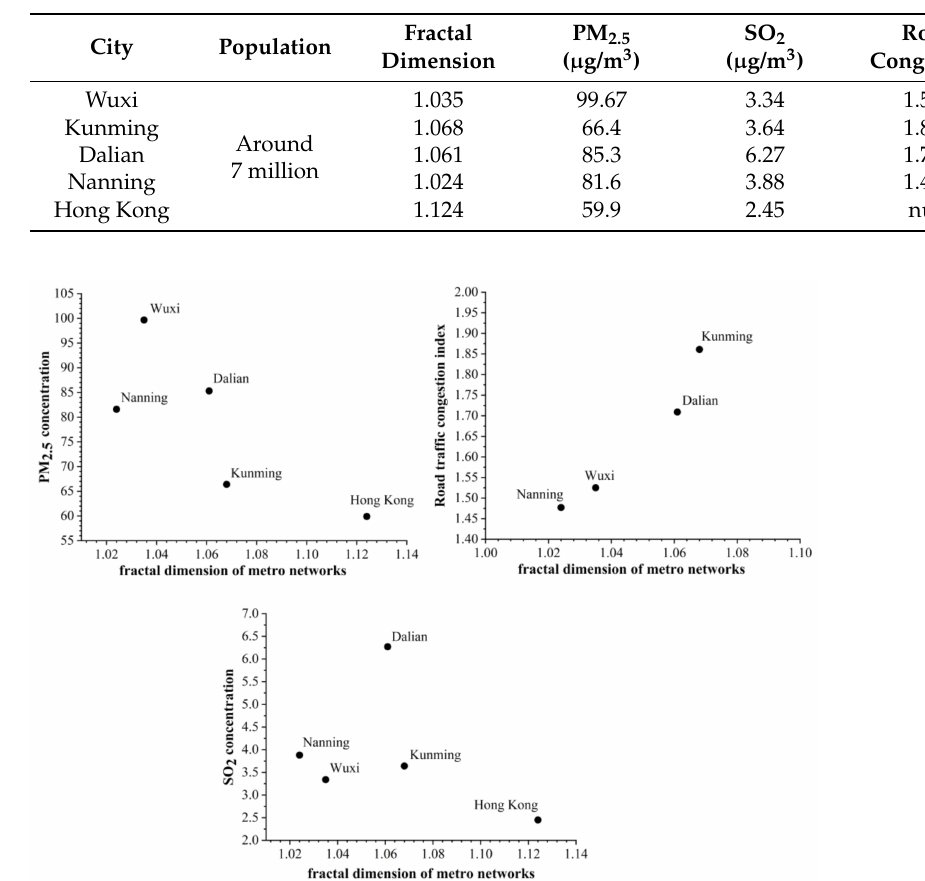
Figure 6. Trends in relations between fractal dimensions and urban quantities for cities with similar population